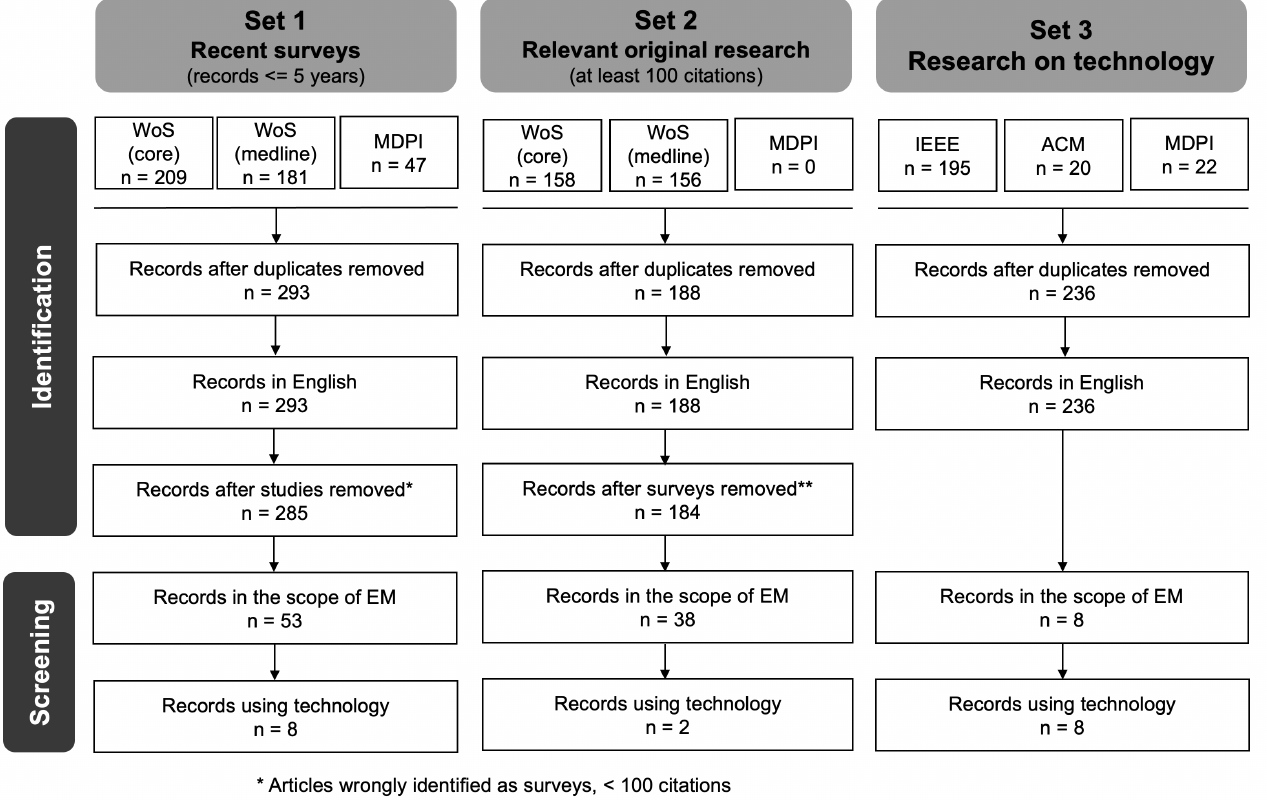
Figure 2. Synthesis of the search, screening and selection